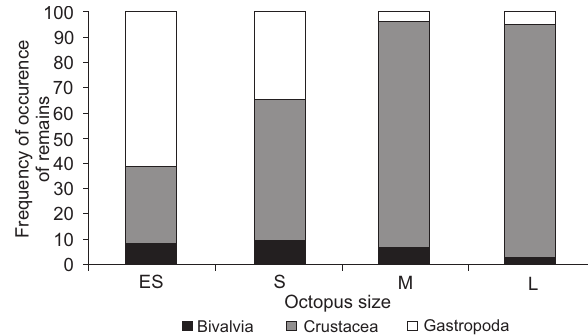
Figure 6. Frequency of occurrences of the food remains (Crusta- cean, Gastropoda and Bivalve) identified in the dens of Octopus insularis , in relation to the four octopus sizes categories.